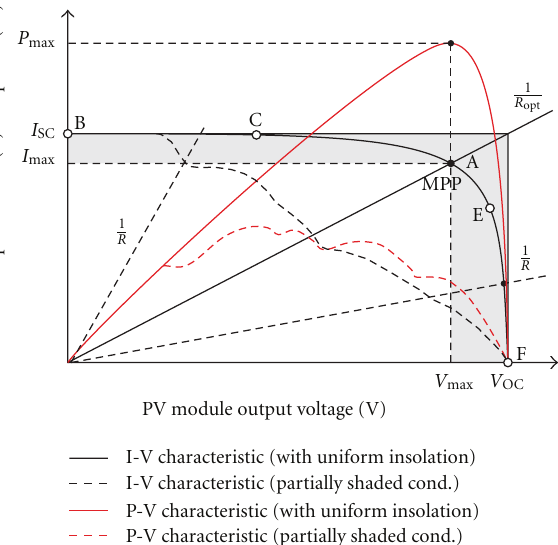
Figure 2: Characteristics of a typical PV cell [7,